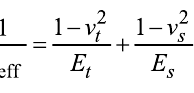
where ε is related to the depth of the energy potential and σ to the length scale of the interaction